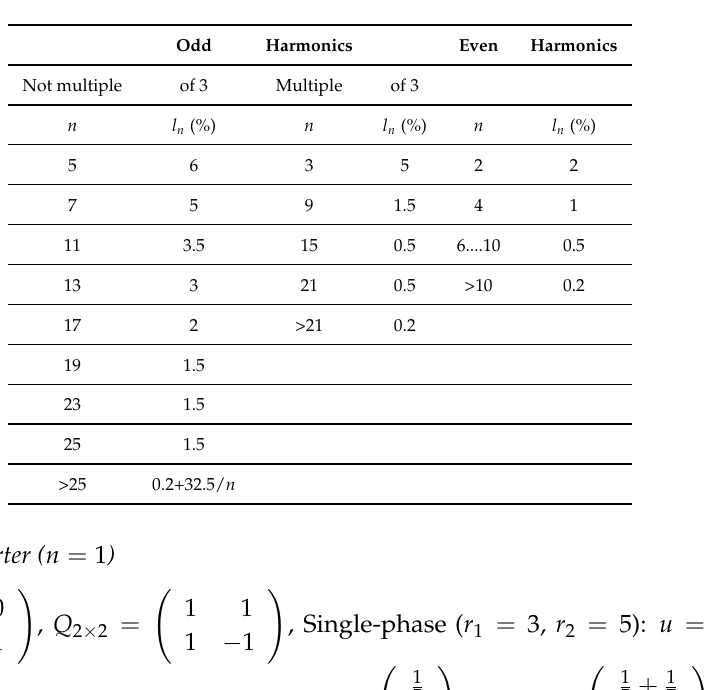
Table 1. Grid codes EN 50160 and CIGRE WG 36-05.